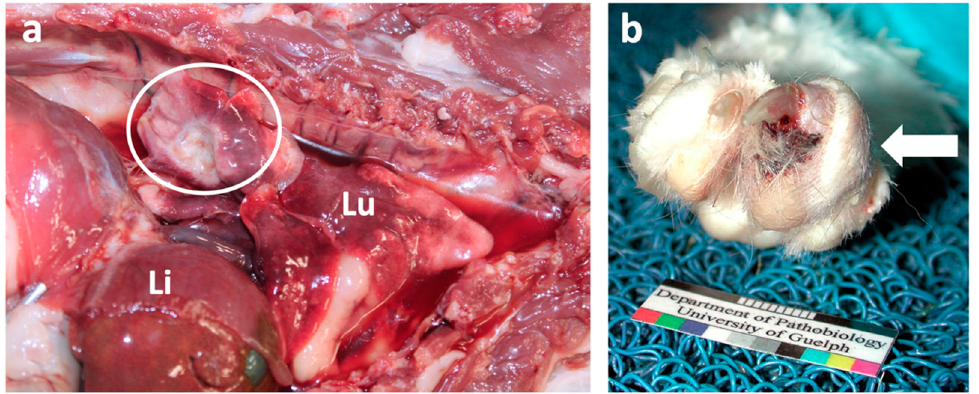
Figure 6. Macroscopic images of a pulmonary carcinoma and digital metastases in a cat. ( a ) Post- mortem examination of a 12-year old female Domestic short hair cat with a focal pulmonary carcinoma (circle) in the right caudal lobe (Lu) and pleural effusion. The liver (Li) is marked for orientation. ( b ) Postmortem examination of a female Domestic short hair cat (of unknown age) with a dig- ital mass (arrow), confirmed to be a metastasis from a pulmonary carcinoma. Photos courtesy of Dr. Jeff Caswell (Department of Pathobiology, University of Guelph).